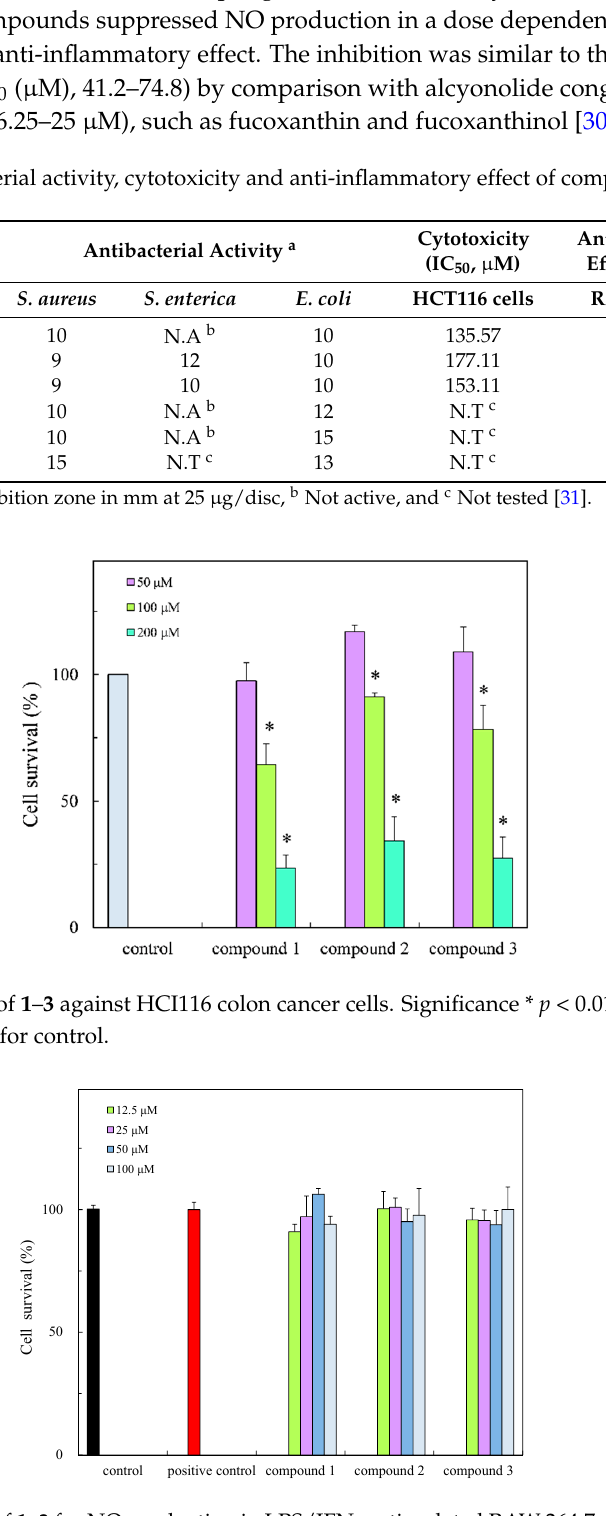
Figure 5. Cytotoxicity of 1 – 3 for NO production in LPS/IFN- γ stimulated RAW 264.7 macrophage cells.